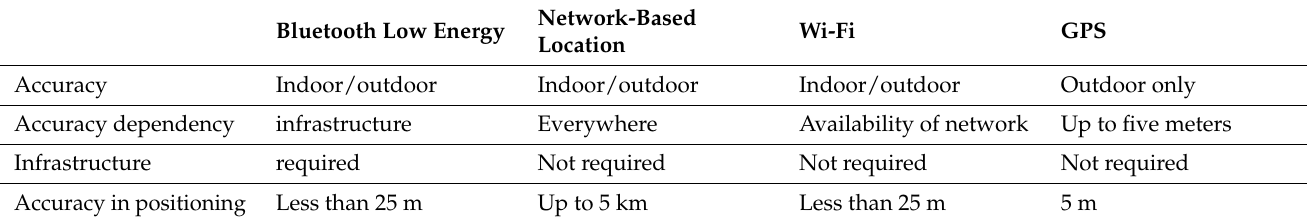
Table 1. Comparisons of different types of